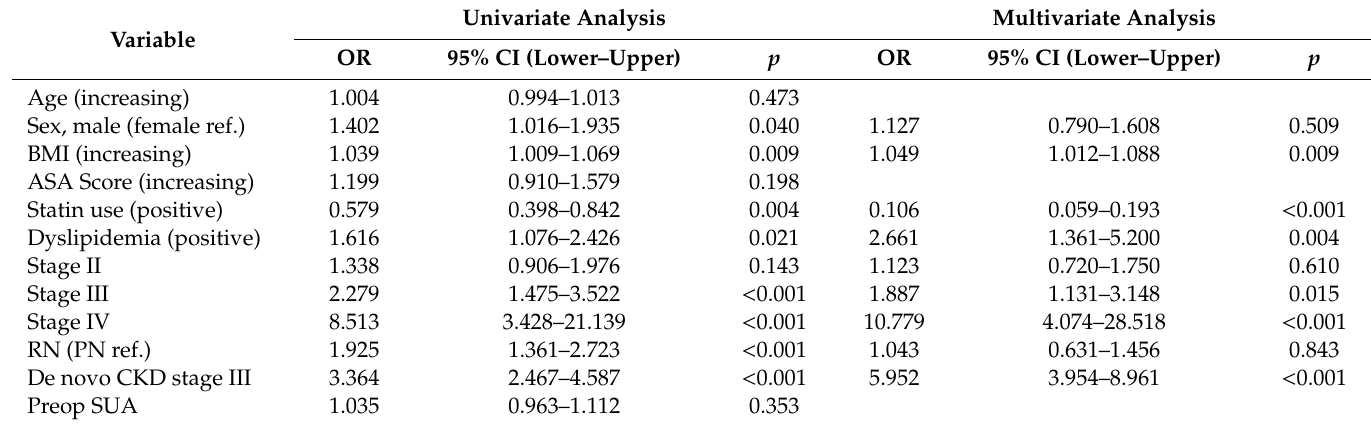
Table 3. Uni and multivariable regression analysis for factors associated with increased postoperative uric acid. Univariate Analysis Variable